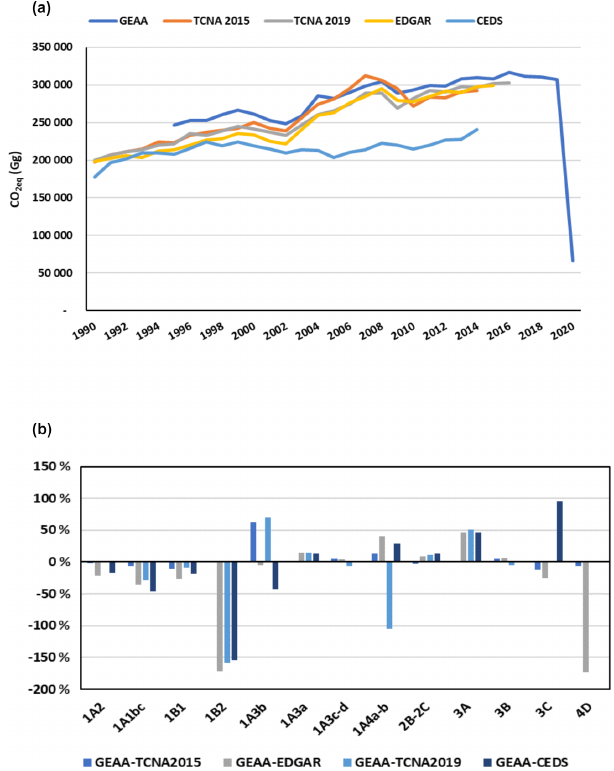
Figure 7. (a) Evolution of total annual CO 2eq Gg emissions for the GEAA (red), TCNA2015 (blue), TCNA2019 (light-blue), EDGAR (green), and CEDS (brown) inventories for Argentina in 1990– 2019 (Tables 5 and A5). (b) Percentage difference in GHG emis- sions ((GEAA − inventory) / GEAA) for 1995 through 2016, for the considered activities (see also Tables A7 and A8). Note that CEDS does not provides N 2 O profiles. GHGs are calculated as (CO 2eq = CO 2 + CH 4 · 25 + N 2 O ·